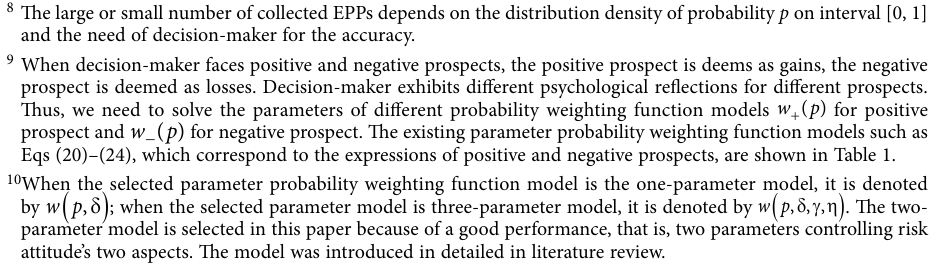
Table 1. Several parametric specifications of